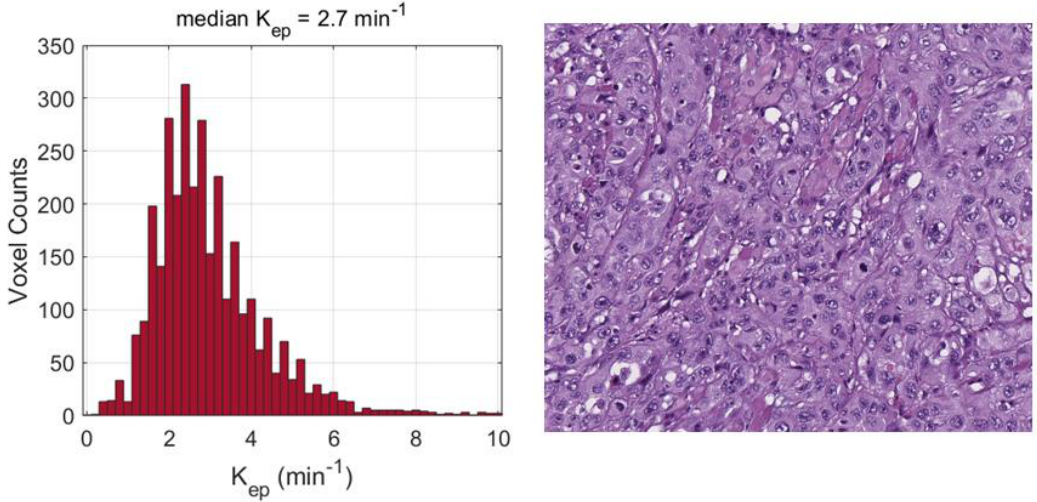
Figure 5. Top (from left to right): central section of a tongue lesion in a 69-year-old man on T2-weighted images (a) and on the corresponding map of K ep (min −1 ), showing a moderately vascularized tumor (median K ep value = 2.7 min −1 ). Bottom (from left to right): histograms of K ep values derived from the entire tumor volume and poorly differentiated squamous cell carcinoma (hematoxylin – eosin; original magnification: 20×).